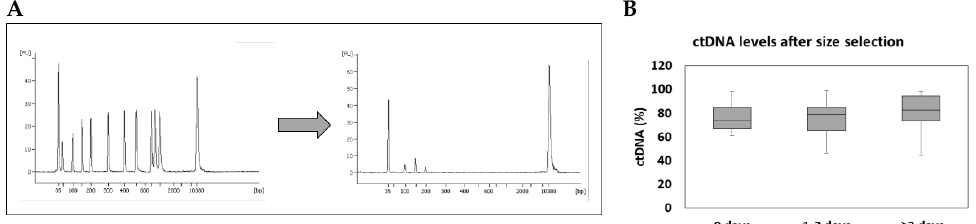
and determined its efficacy by an analysis with the Agilent Bio-Analyzer 2100.